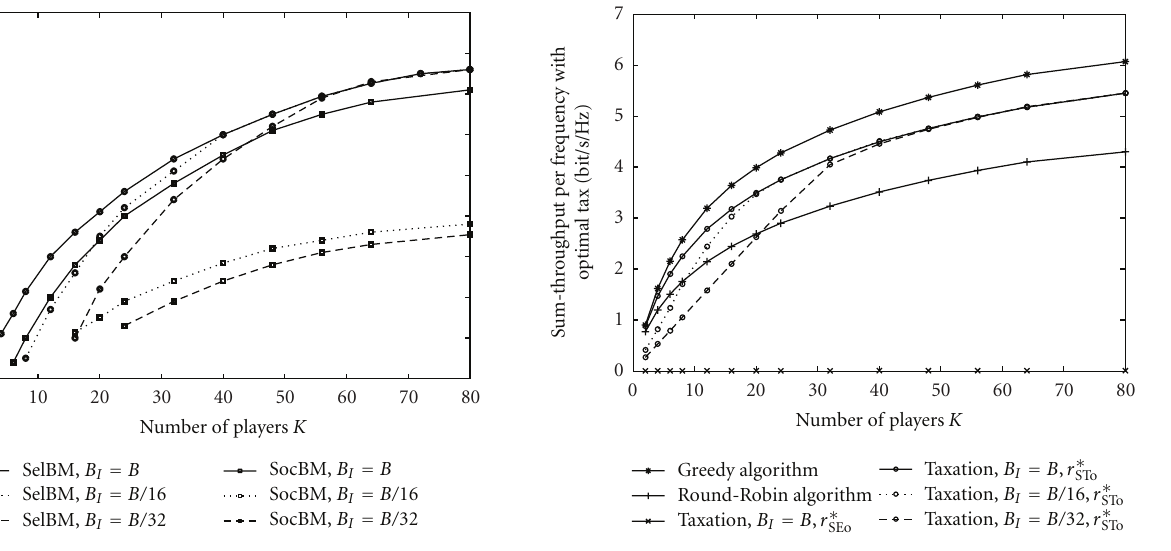
versus the Figure 8: Average sum throughput for the optimal tax rate for both ST 0 SelBM and SocBM; two-path channel model.